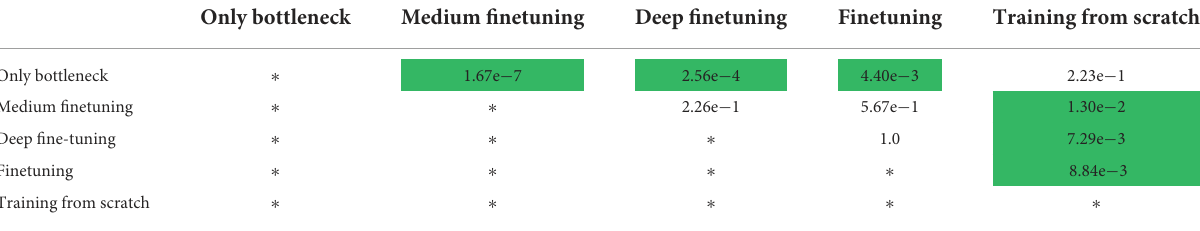
TABLE 5 Bonferroni-corrected p -values of independent t -tests for each pair of transfer learning strategies. Only bottleneck Medium finetuning Deep finetuning Finetuning Training from scratch